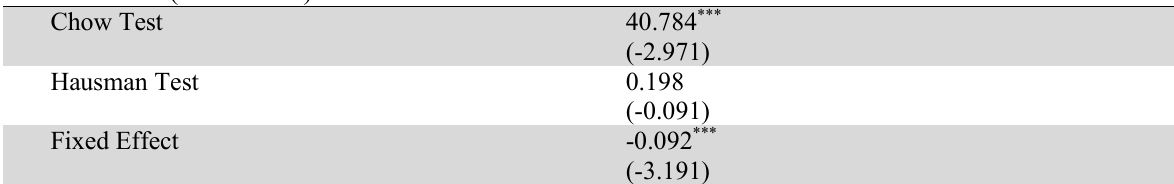
IOS Influence (MVABVA) on DER